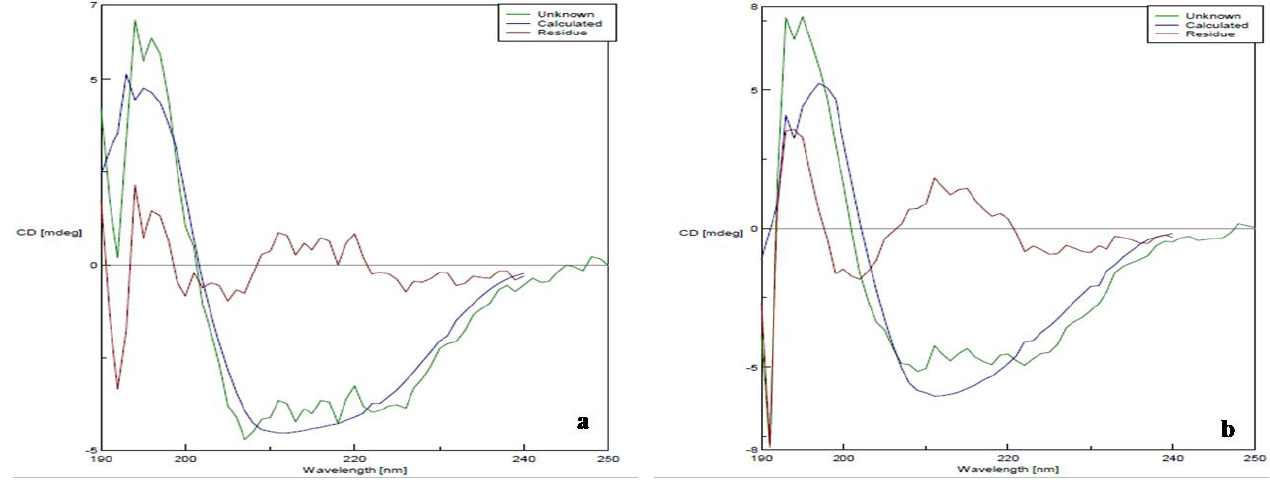
Figure 7. CD spectra of a) LcrV and b) formulation PD1 after 3 weeks in the “ far-UV ” spectral region.